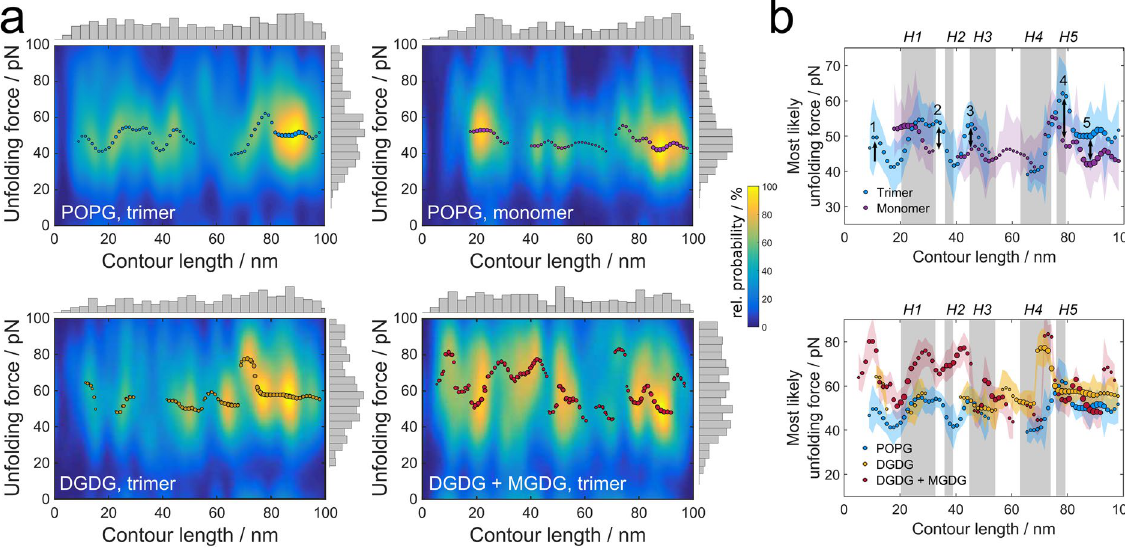
Figure 2. Unfolding forces of LHCII depend on trimerization and the lipid matrix. ( a ) Multivariate kernel density estimate of the unfolding force as a function of the contour length for LHCII monomers in POPG (top right) and LHCII trimers in POPG (top left), pure DGDG (bottom left) and a mixture of DGDG and MGDG (bottom right). The dots mark the most likely unfolding forces for a given contour length, while the diameter of the dots represents their relative probability of at least 40% in relation to the most probable unfolding event. The histograms (grey) at the axes show the individual underlying distributions of unfolding forces and contour lengths. ( b ) Most likely unfolding force as a function of the contour length (obtained from the dots in ( a )) as a function of oligomerization state (top) and lipid mixture (bottom). Helices (H1-5) are indicated as shaded gray areas. The color shaded areas indicate the standard error of the most likely unfolding force. The trimer shows enhanced stabilization compared to the monomer in distinct domains of the protein, indicated by numbers 1 to 5. Both glycolipids provide additional stability for trimeric LHCII at helix 4, while the addition of MGDG strongly increases the unfolding forces in many segments along the LHCII